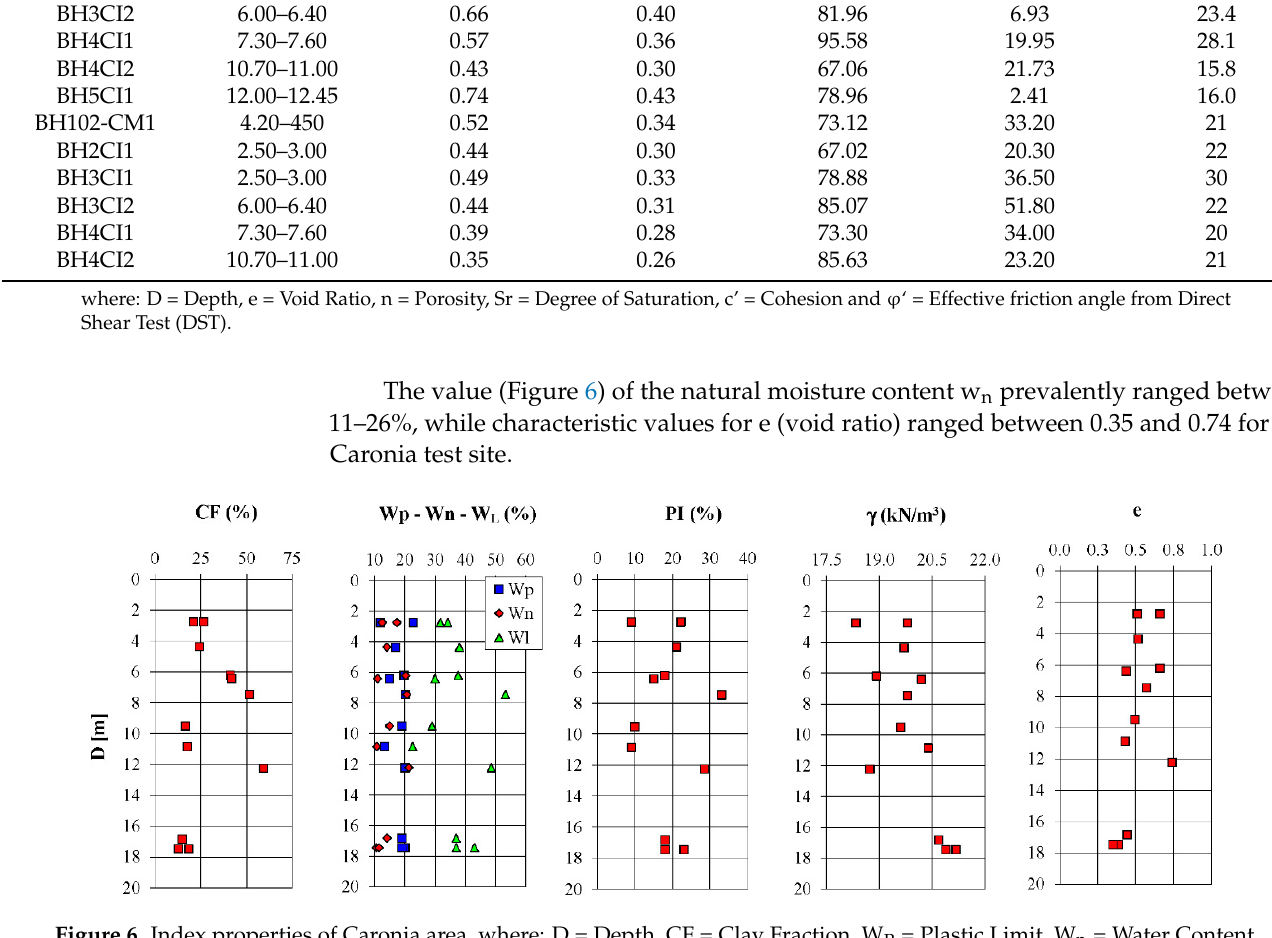
Table 3. Mechanical characteristics for Caronia area.